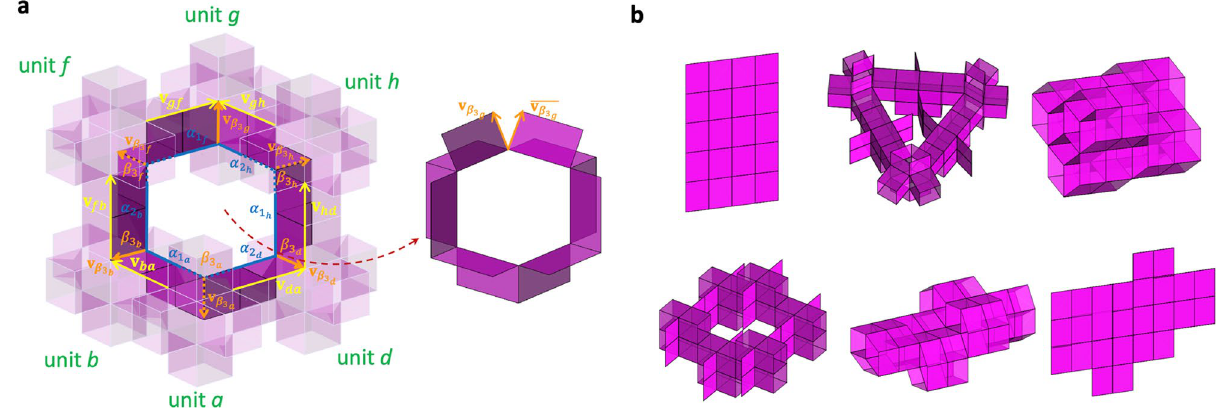
Figure 6. ( a ) Angular kinematics to determine mobility of the extended unit cell with spatial closed-loops and ( b ) its transformed